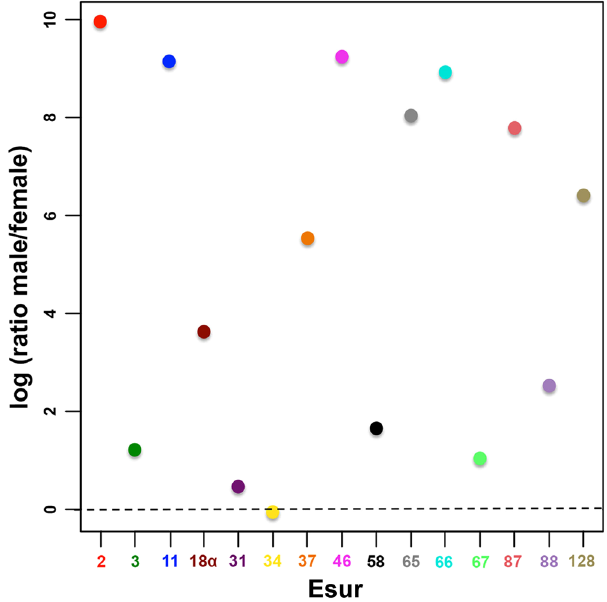
Figure 4. Copy number variation between male vs female genomes of 15 satDNAs with monomers > 60 bp in E . surinamensis . The male/female ratio of a relative copy number is shown on a logarithmic scale. The qPCR of male and female genomic DNA was used to calculate the satDNA dose by a Δ Ct method of relative quantification (see Supplementary Table S3). Each satDNA family (Esur) is represented by numbers and colors directly in the images. Note that most satDNAs differ significantly between sexes with males having a higher copy number than females for most repeats studied. The statistical significance for difference in copy number between males and females using chi-squared test was highly significant, p -value < 0.01 for each